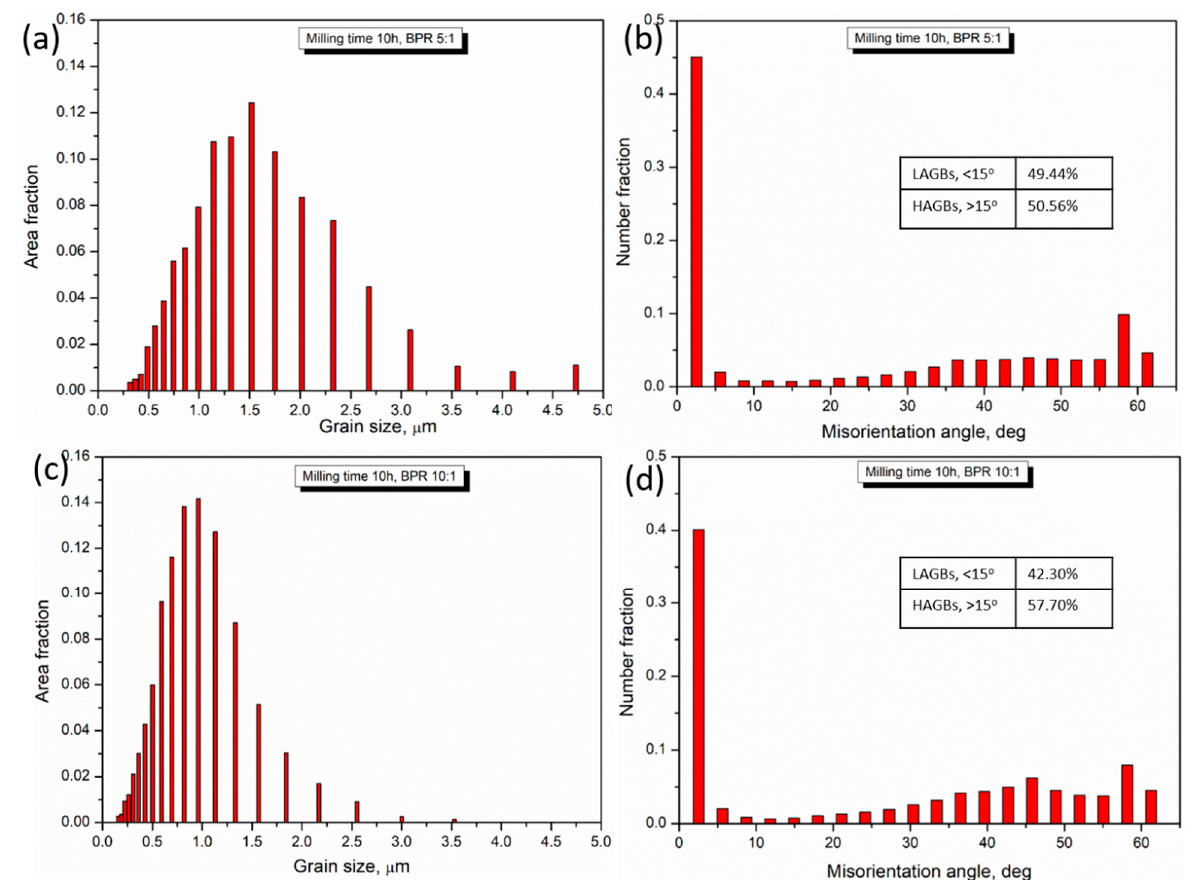
Figure 8. Grain size distribution Vs area fraction of FeMn30Cu5 hot-forged biodegradable alloys processed at different milling conditions: ( a ) 10 h and BPR 5:1 sample; ( c ) 10 h and BPR 10:1; Misorientation angle Vs number fraction of FeMn30Cu5 hot-forged biodegradable alloys processed at different milling conditions: ( b ) 10 h and BPR 5:1 sample; ( d ) 10 h and BPR 10:1.